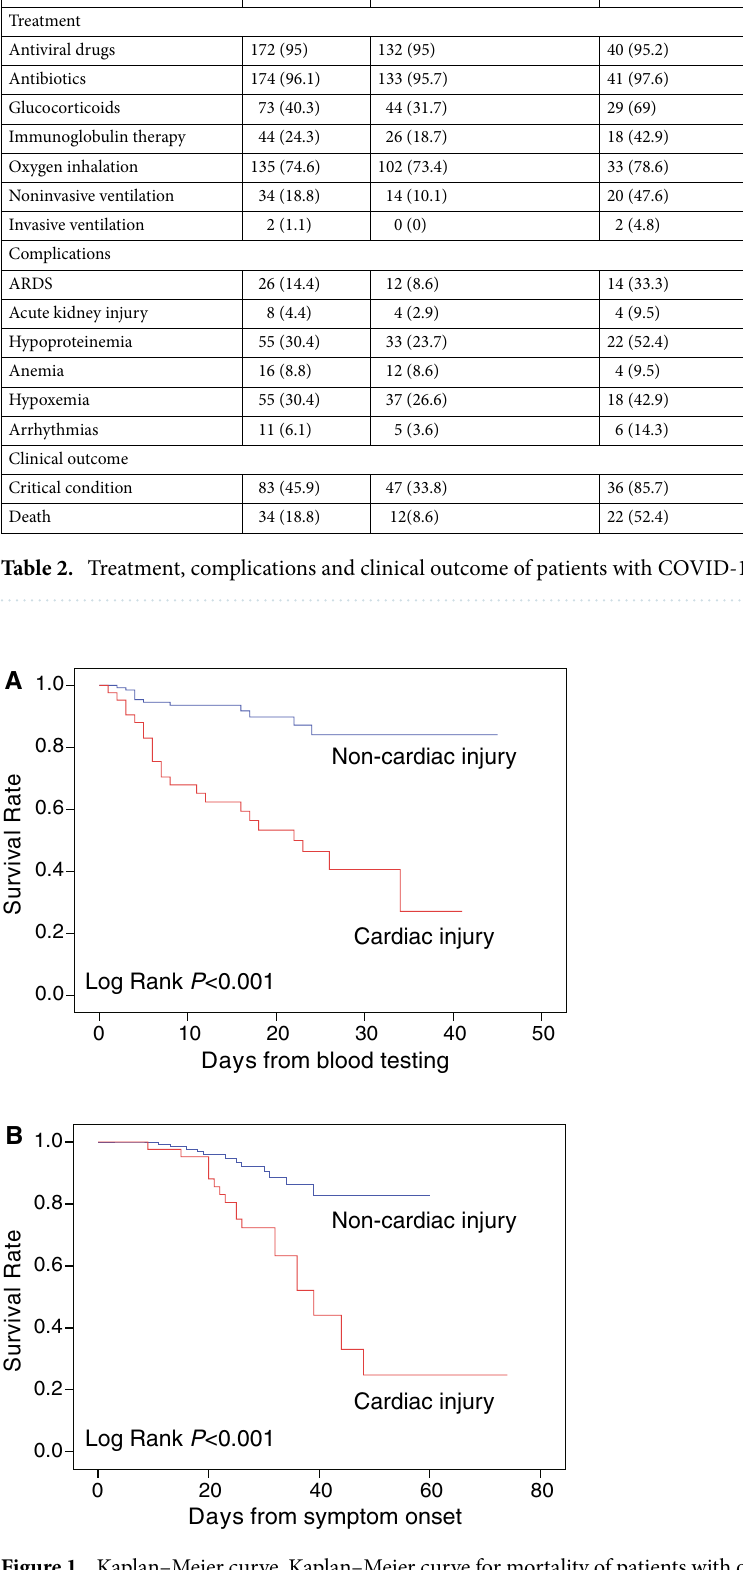
Figure 1. Kaplan–Meier curve. Kaplan–Meier curve for mortality of patients with or without cardiac injury during the time from blood testing ( A ) and symptom onset ( B